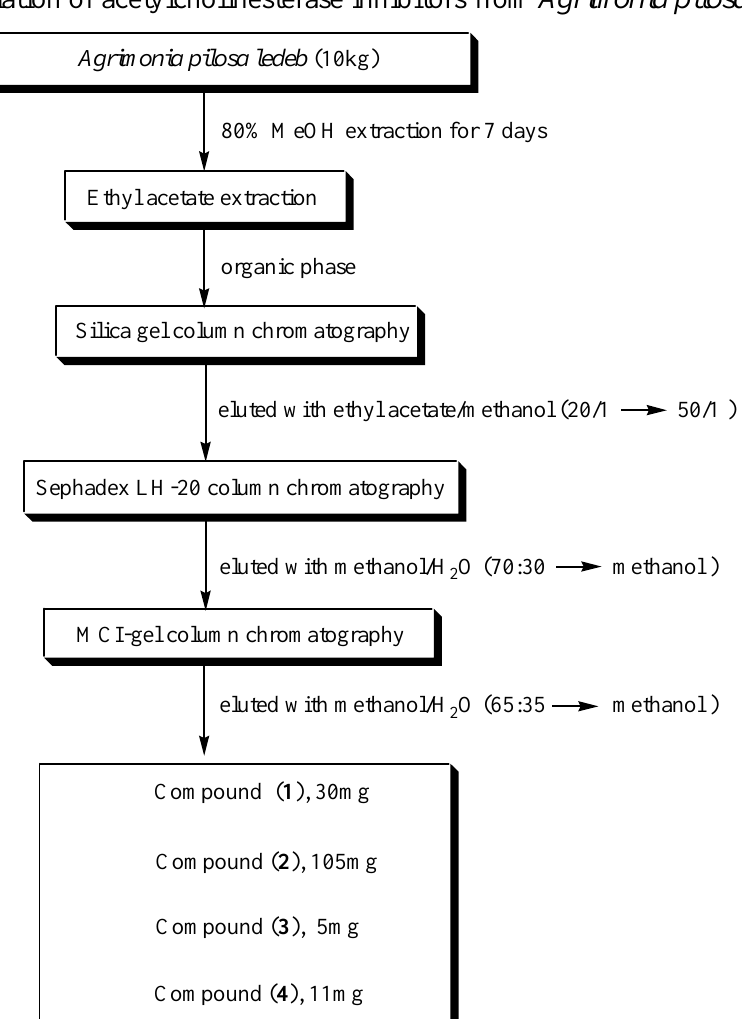
Figure 1. Isolation of acetylcholinesterase inhibitors from Agrimonia pilosa ledeb.